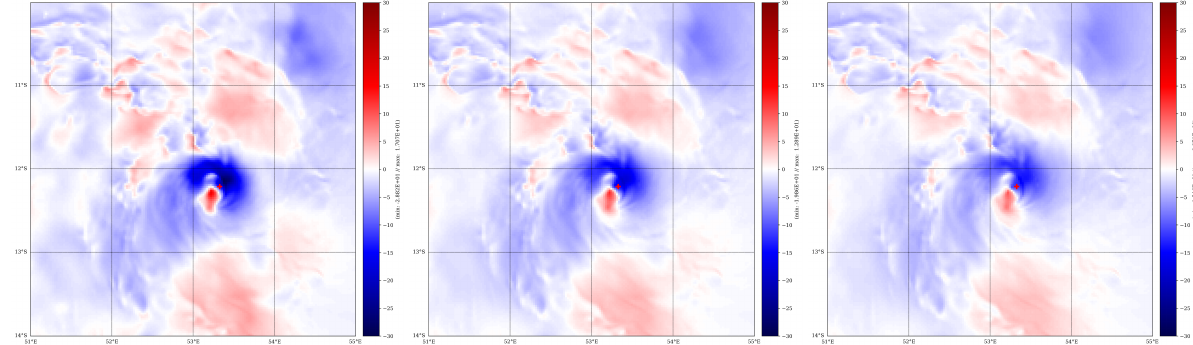
Figure 18. Analysis increments for surface wind speed with observation errors of 2 m · s − 1 ( left ), 4 m · s − 1 ( middle ), 6 m · s − 1 ( right ) for SAR data assimilation. Units are m · s − 1 . Red cross is the estimated TC center position interpolated from TC position extracted from BT on 7 February 2019 00:00Z and 06:00Z.